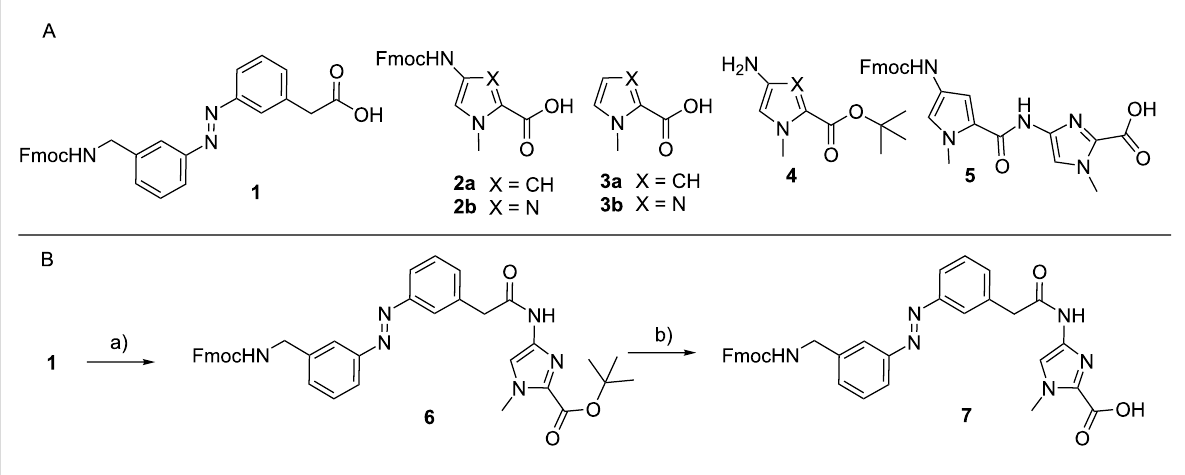
Scheme 2: Building blocks required for the synthesis of the photoswitchable Im/Py polyamides. A) Fmoc–Azo–OH 1 , N- methylpyrrole and N- methyl- imidazole monomers 2 – 4 , and Fmoc–Py–Im–OH 5 . B) Synthesis of the dimer Fmoc–Azo–Im–OH 7 : a) DCC, THF, rt, 5 min, then 4 , rt, 15 h, 41%;